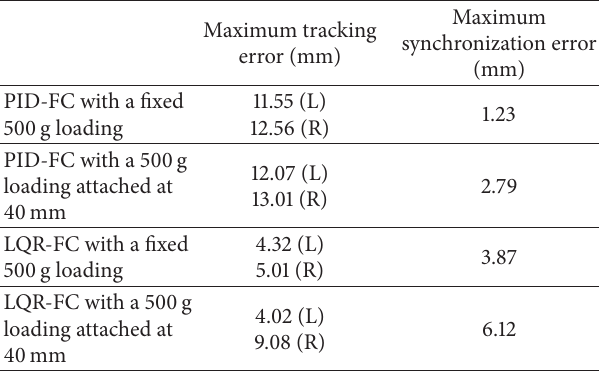
Table 3: Comparison of the disturbance rejection between PID-FC and LQR-FC controllers with a 500 g